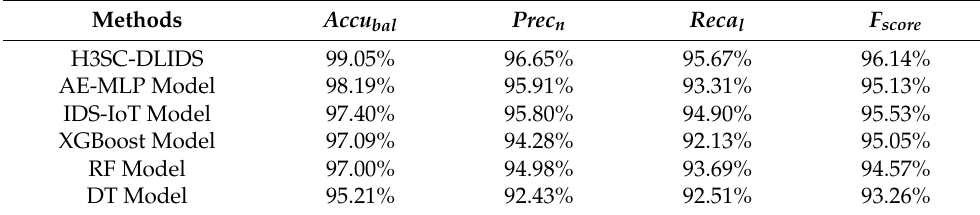
Table 5. Comparative analysis results of the proposed H3SC-DLIDS technique and other systems.